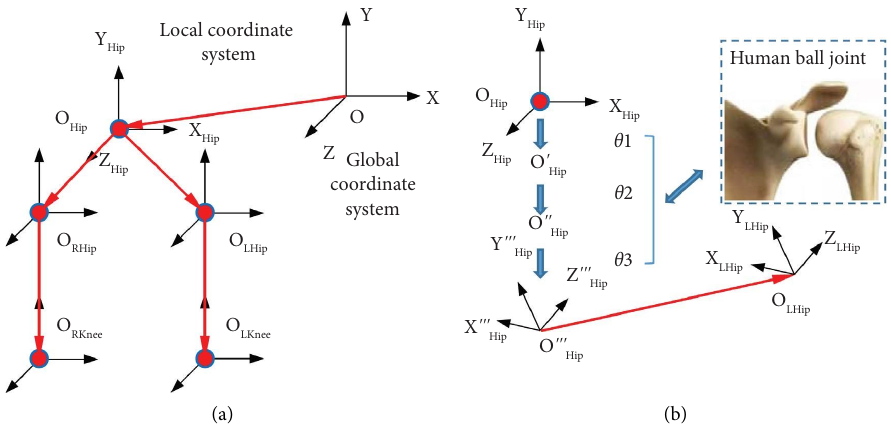
Figure 4: Schematic diagram of the establishment and transformation rules of coordinate